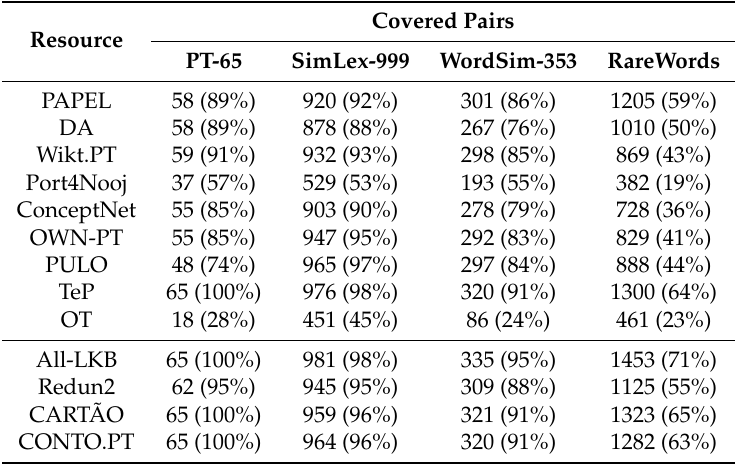
Table 6. Coverage of the pairs of each similarity test by each LKB used. Covered Pairs Resource PT-65 SimLex-999 WordSim-353